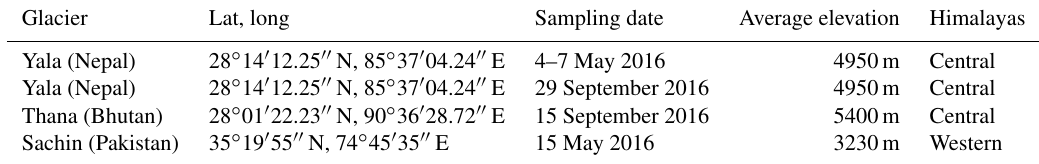
Table 1. Snow sampling time and locations from selected glaciers. Glacier Lat,